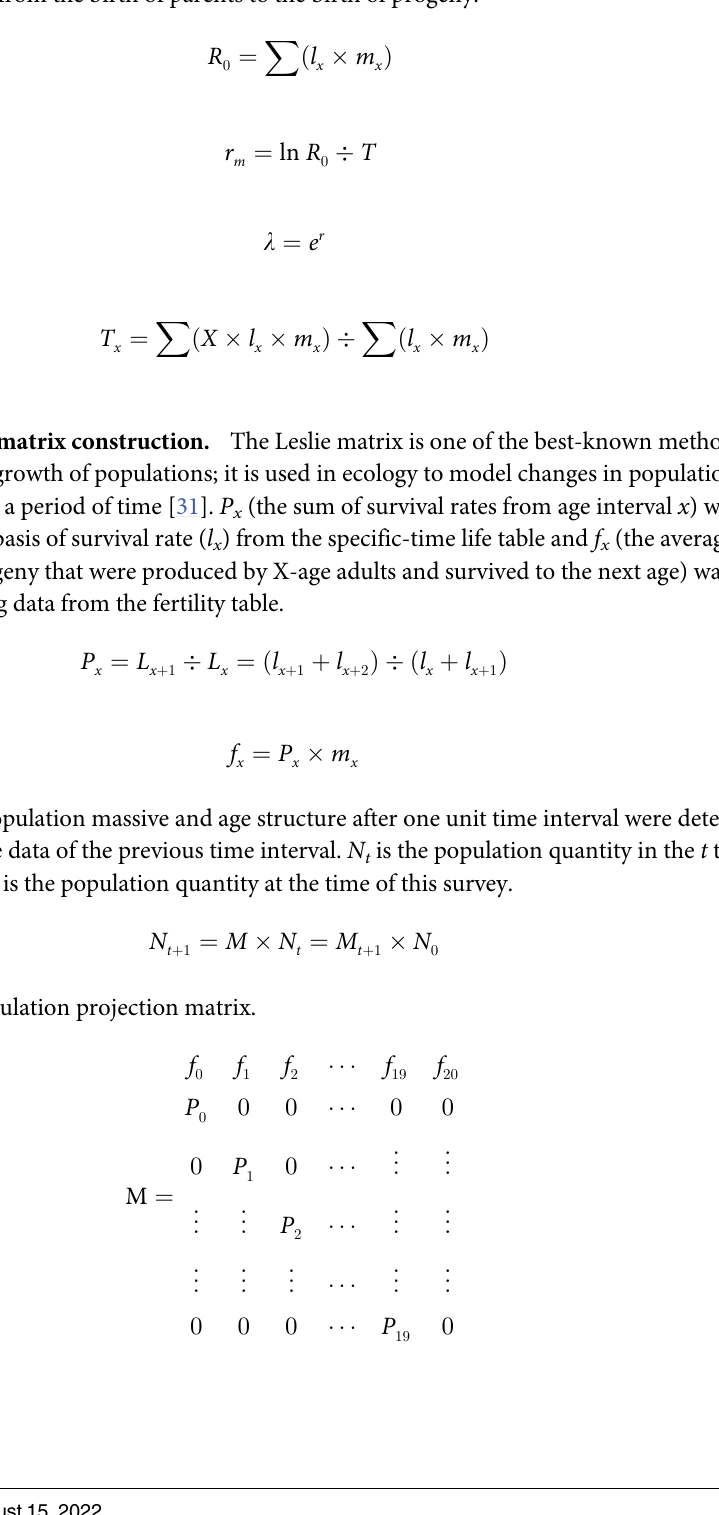
as the net repro- 0 as the x